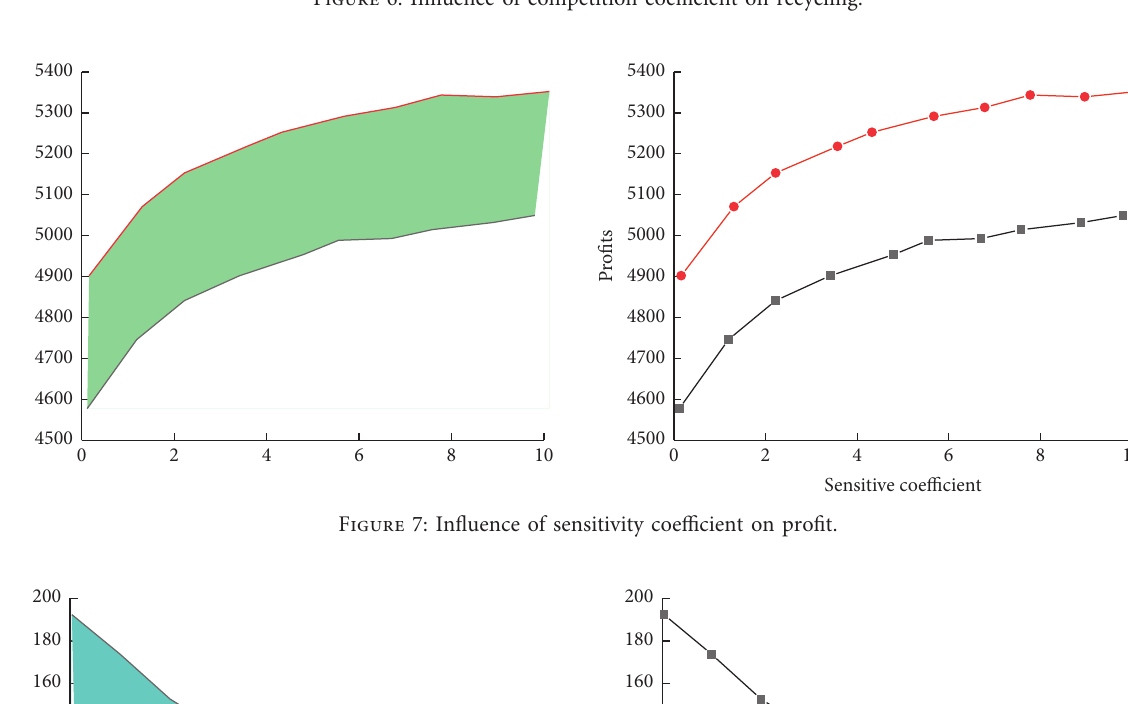
Figure 6: Influence of competition coefficient on recycling.